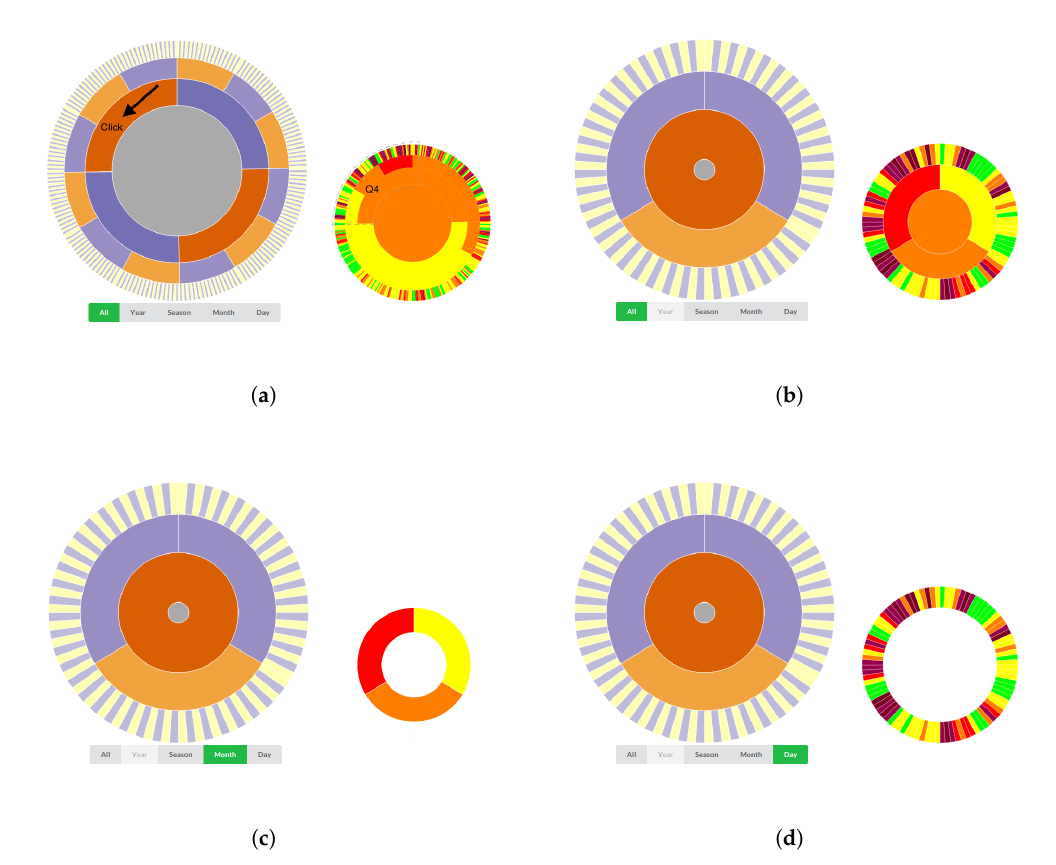
Figure 8. Temporal navigation. The left circle symbol shows the structure of the time symbol, and the right is the map symbol that will be displayed on the map. The toggle buttons below are for the time filter to focus on the time granularities of interest. ( a ) shows the full year data in a time symbol, and ( b ) shows the zoomed symbol to Quarter 4 (October, November and December). ( c , d ) show the symbols that are filtered by the month and day